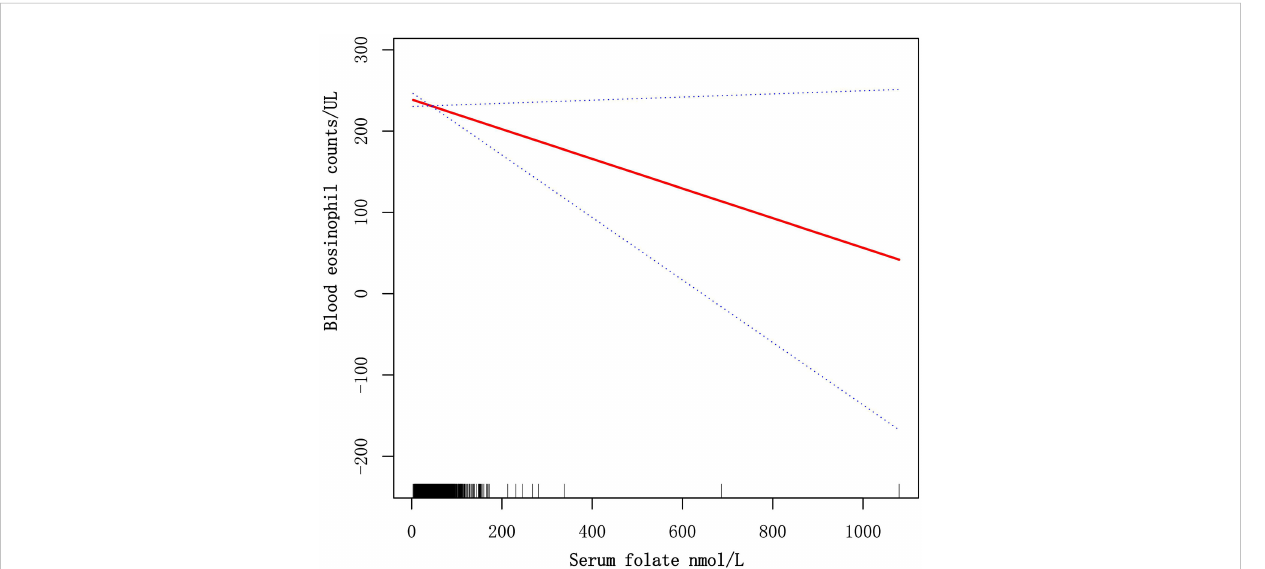
FIGURE 3 Dose-response relationships of serum folate levels with blood eosinophil counts. The solid red line represents the smooth fi tting curve between serum folate levels with blood eosinophil counts, and the blue dotted line represents the 95% CIs of the fi